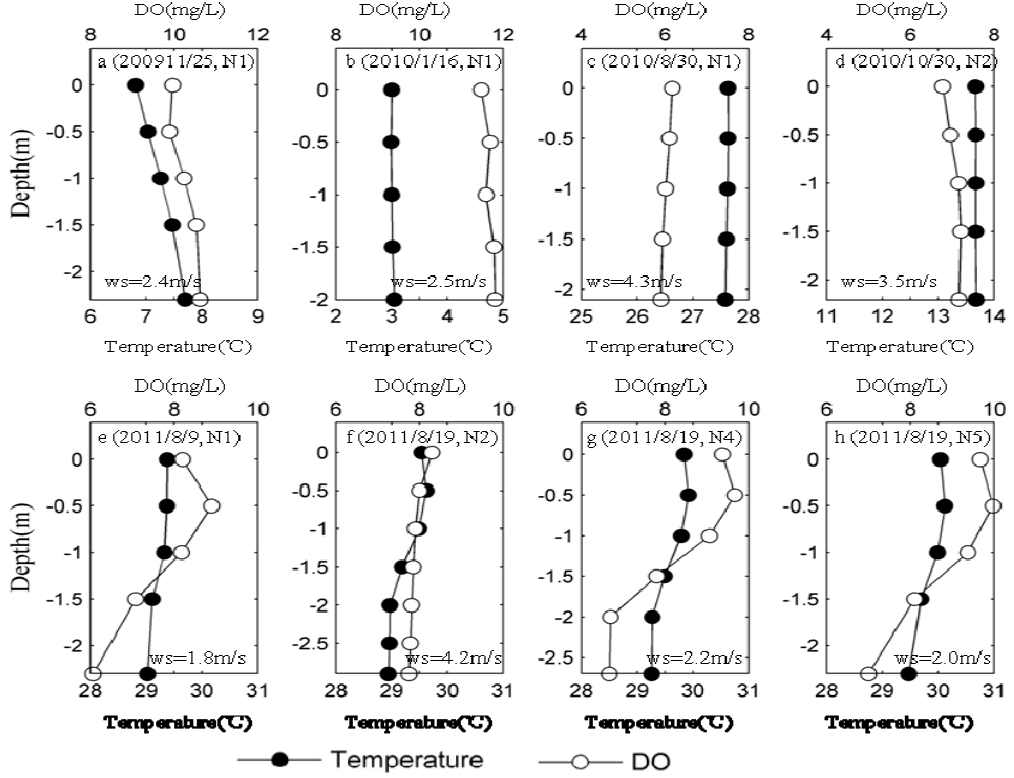
Figure 4. Profiles of temperature and DO in the lacustrine zone (N1-N5): ( a ) 2009/11/25 at N1; ( b ) 2010/1/16 at N1; ( c ) 2010/8/30 at N1; ( d ) 2010/10/30 at N2; ( e ) 2011/8/9 at N1; ( f ) 2011/8/19 at N2; ( g ) 2011/8/19 at N4; ( h ) 2011/8/19 at N5. “ws” represents the mean wind speed during the study